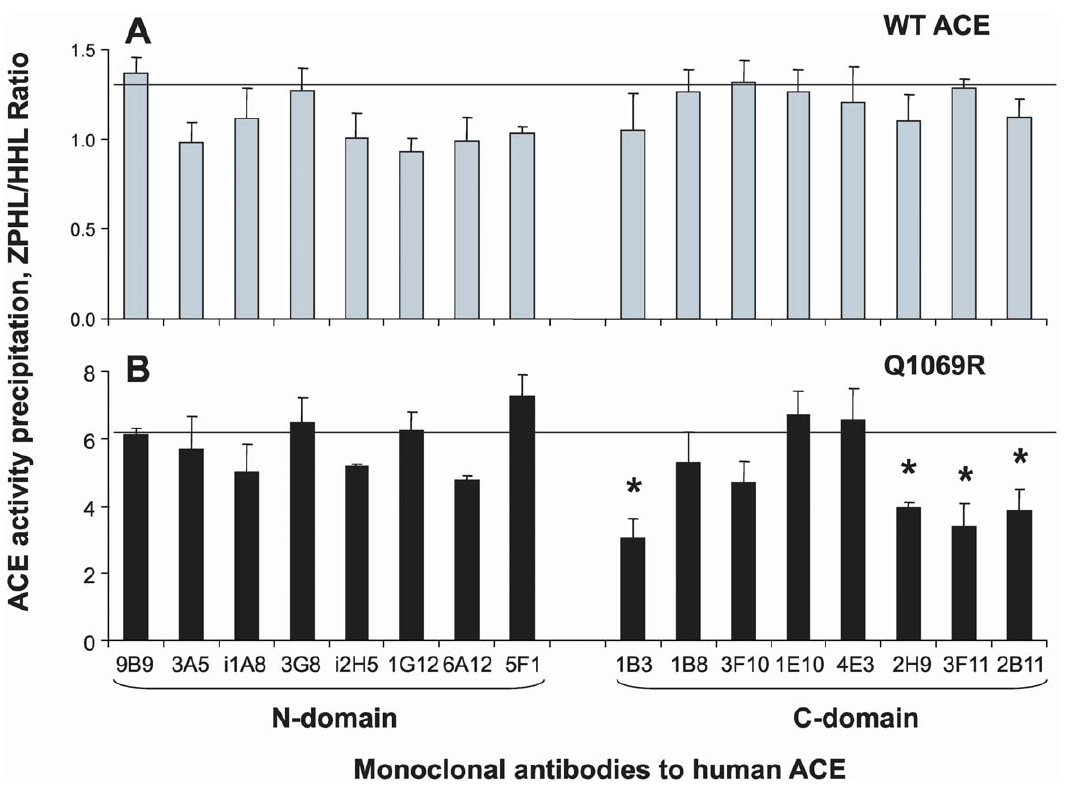
Figure 9. Catalytic properties of mutant ACE bound to ACE mAbs. Membrane-bound WT ( A ) and mutant ACE ( B ) lysates were normalized to achieve 5 mU/ml ACE activity with Z-Phe-His-Leu as substrate and incubated in microtiter plates covered by 16 mAbs to human ACE as in Fig. 7. ACE activity precipitated by each mAb was quantified by fluorimetric assay with two substrates (Hip-His-Leu and Z-Phe-His-Leu) as in Fig. 5. Data are expressed as the ratio of ACE activity precipitated by each mAb determined with each substrate. Data are mean 6 SD of 6–8 independent experiments in duplicate. * - p , 0.05 vs. ZPHL/HHL ratio for corresponding values of WT and mutant ACE in solution (horizontal lines in A and B). The ratio for duplicate samples of WT ACE or mutant ACE was approximately 1.0 and the SD was less than